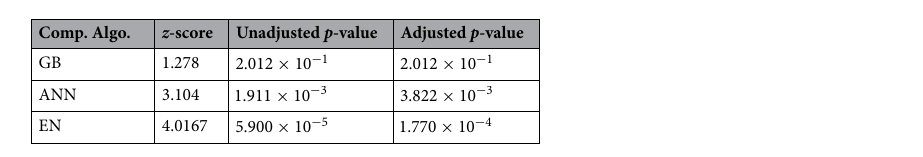
Table 9. Adjusted p -values using Hochberg multiple comparison test.